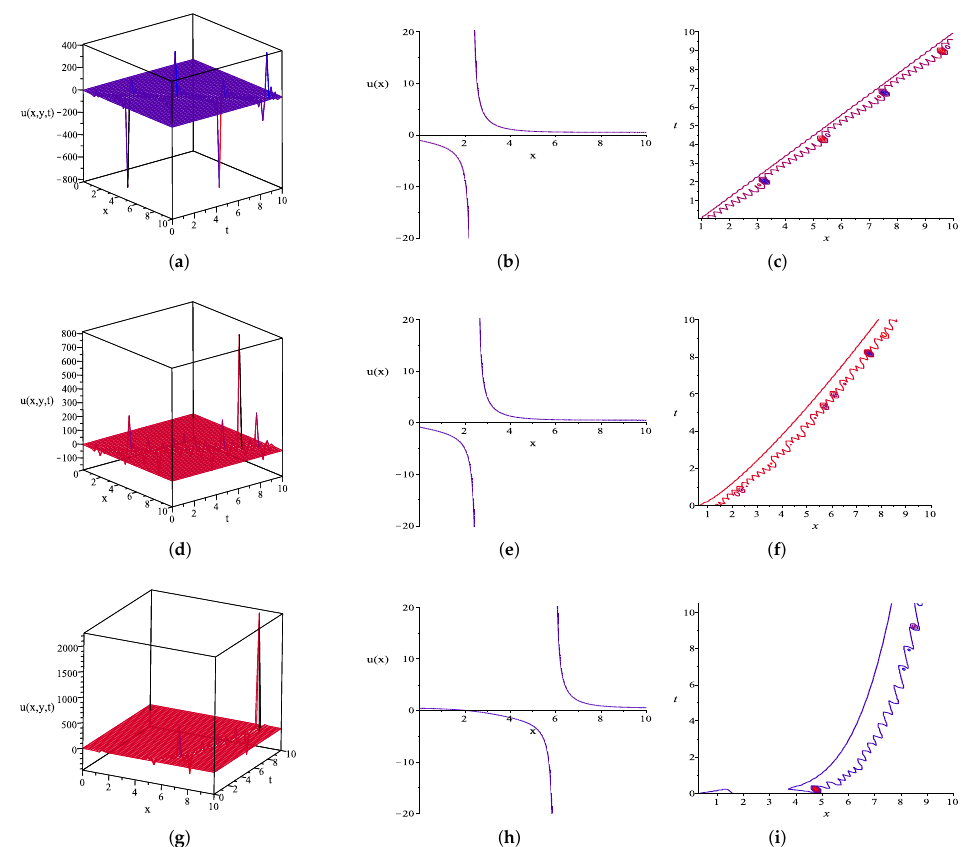
Figure 3. Associated plots of u 2 ( x , y , t ) in Equation (43) obtained using the generalized Kudryashov method: ( a – c ) 3-D plot, 2-D plot, and contour plot, respectively when α = 1; ( d – f ) 3-D plot, 2-D plot, and contour plot, respectively when α = 0.8; ( g – i ) 3-D plot, 2-D plot, and contour plot, respectively when α = 0.2.